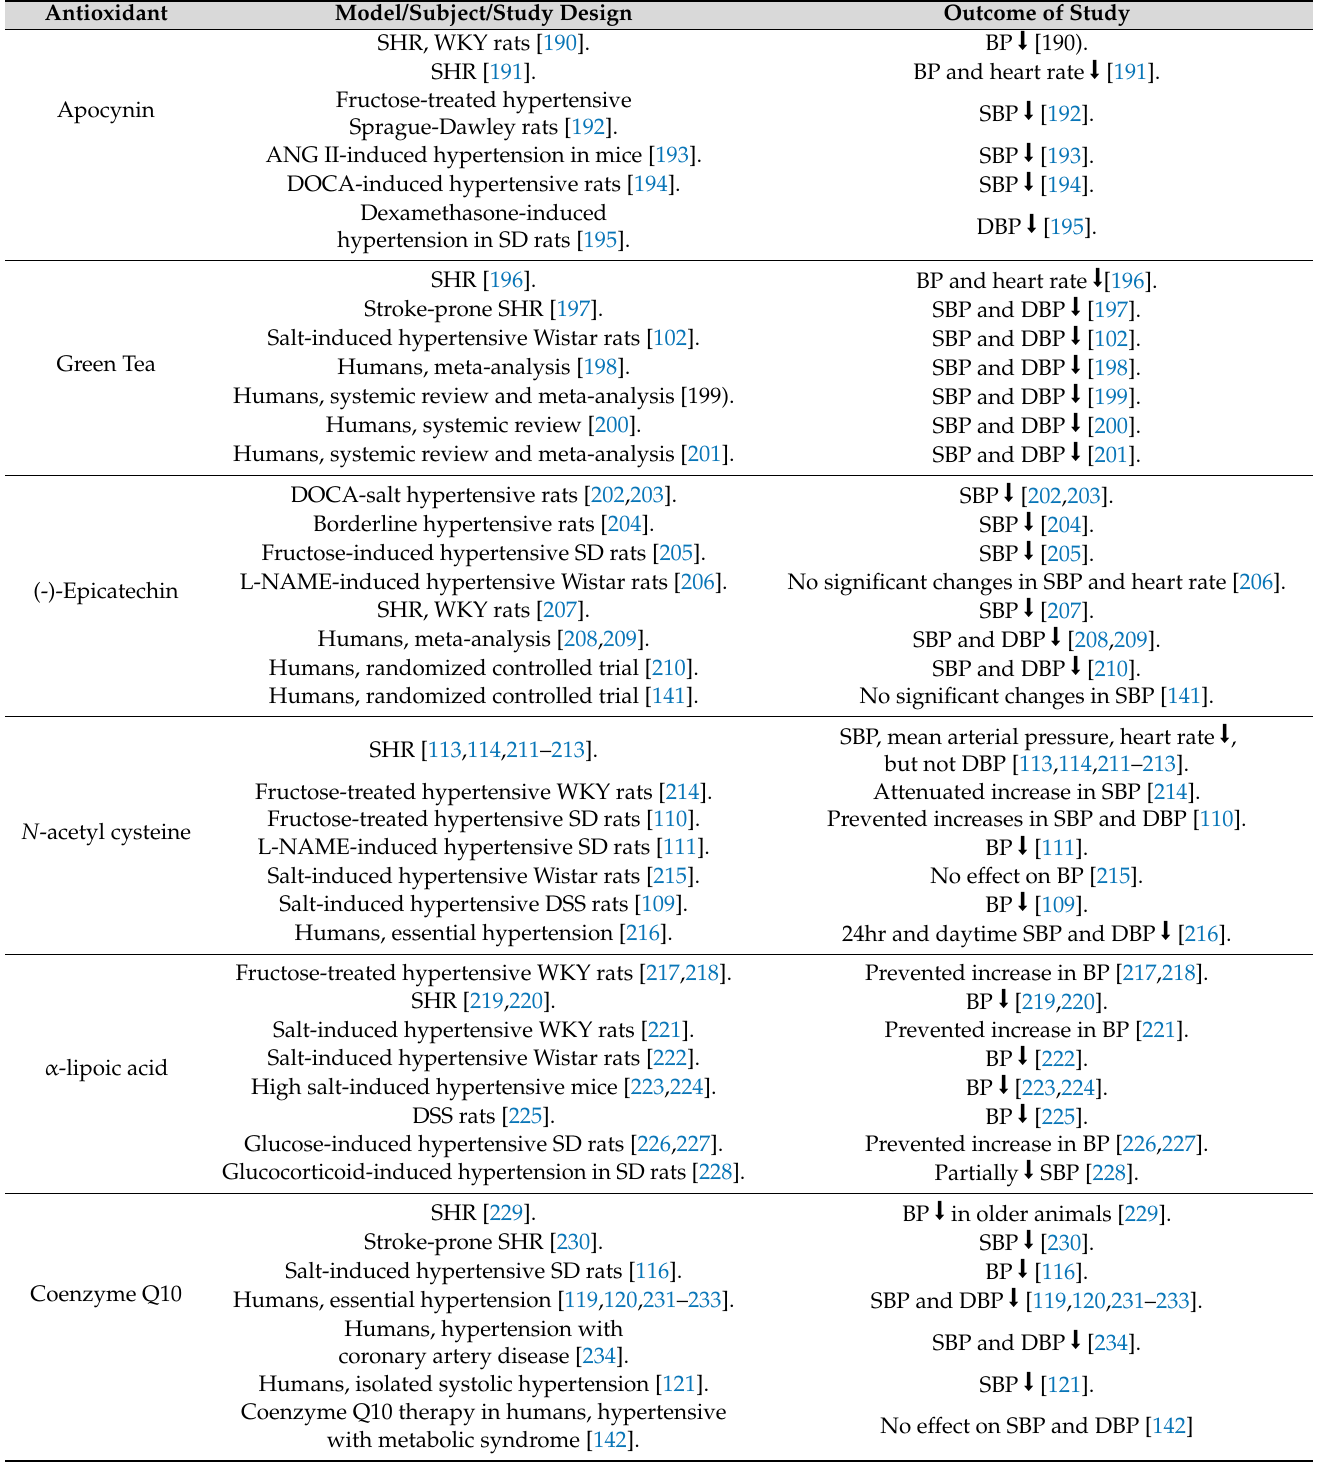
Vitamin C Vitamin C Vitamin C